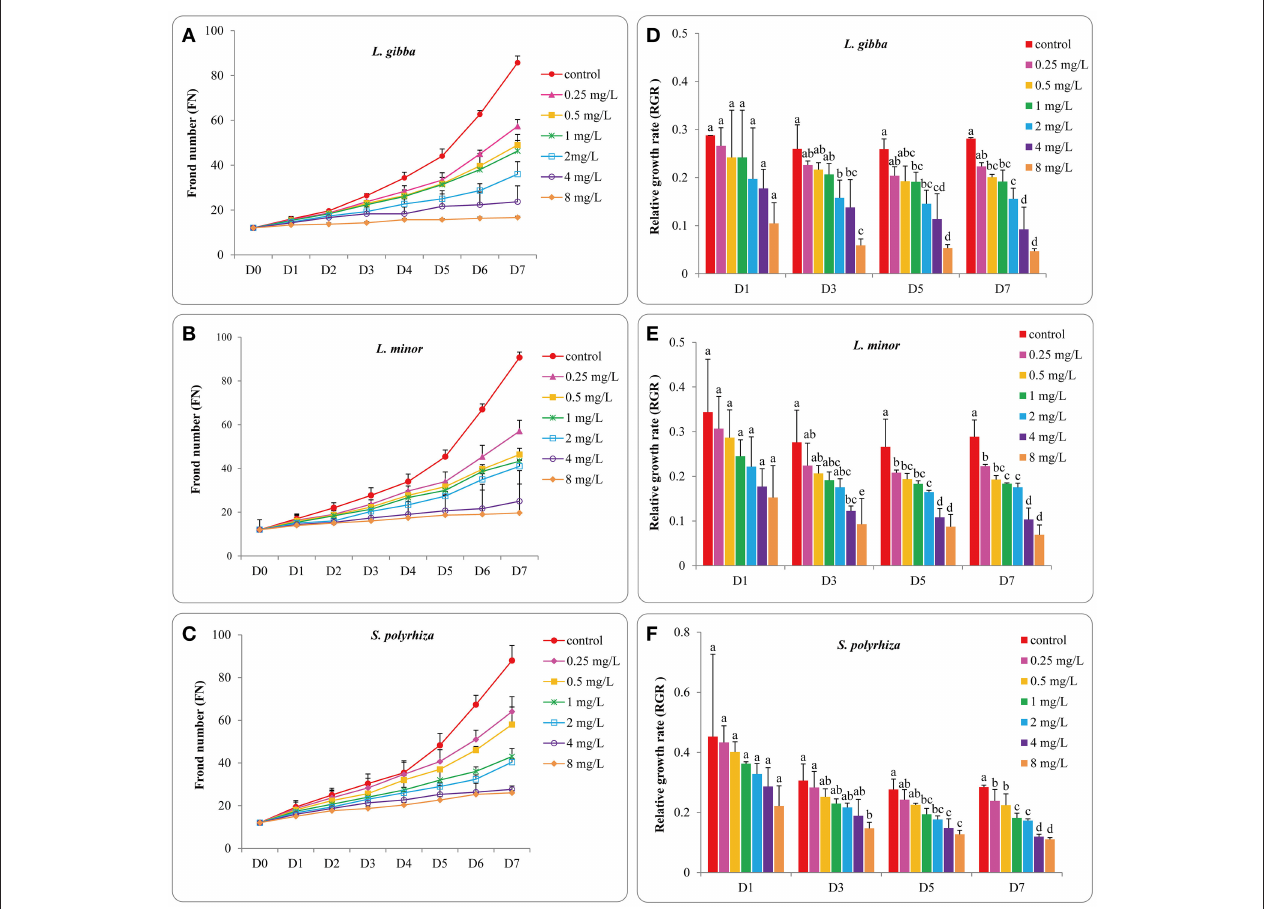
FIGURE 1 | Effects of different concentrations of Hg on the frond number and the corresponding relative growth rates of L. gibba (A,D) , L. minor (B,E) and S. polyrhiza (C,F) at 1, 3, 5, 7 days. The letters (a, b, c, d, e) on the column graphs indicated Tukey tests analyses results among different Hg treatments at 1, 3, 5, 7 days in the same duckweed. The same letters indicated no significant differences and different letters indicated significant difference among treatments. Error bars indicated standard deviation.